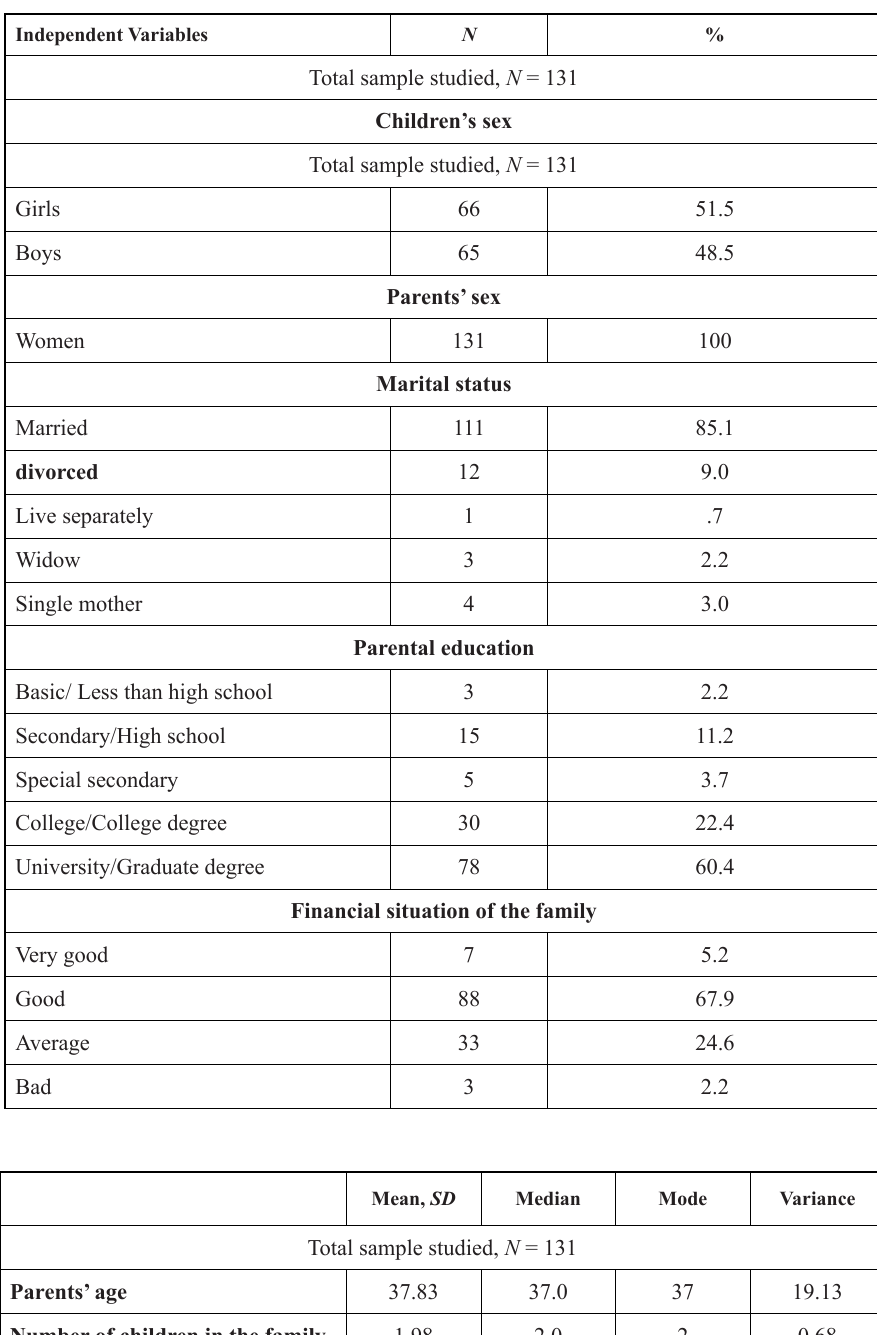
Jolanta Žilinskienė, Linas Šumskas, Dalia Antinienė, Jolita Jonynienė